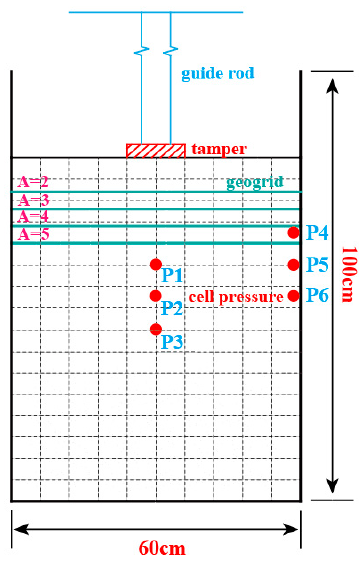
Table 1. Mechanical properties of the soil sample.